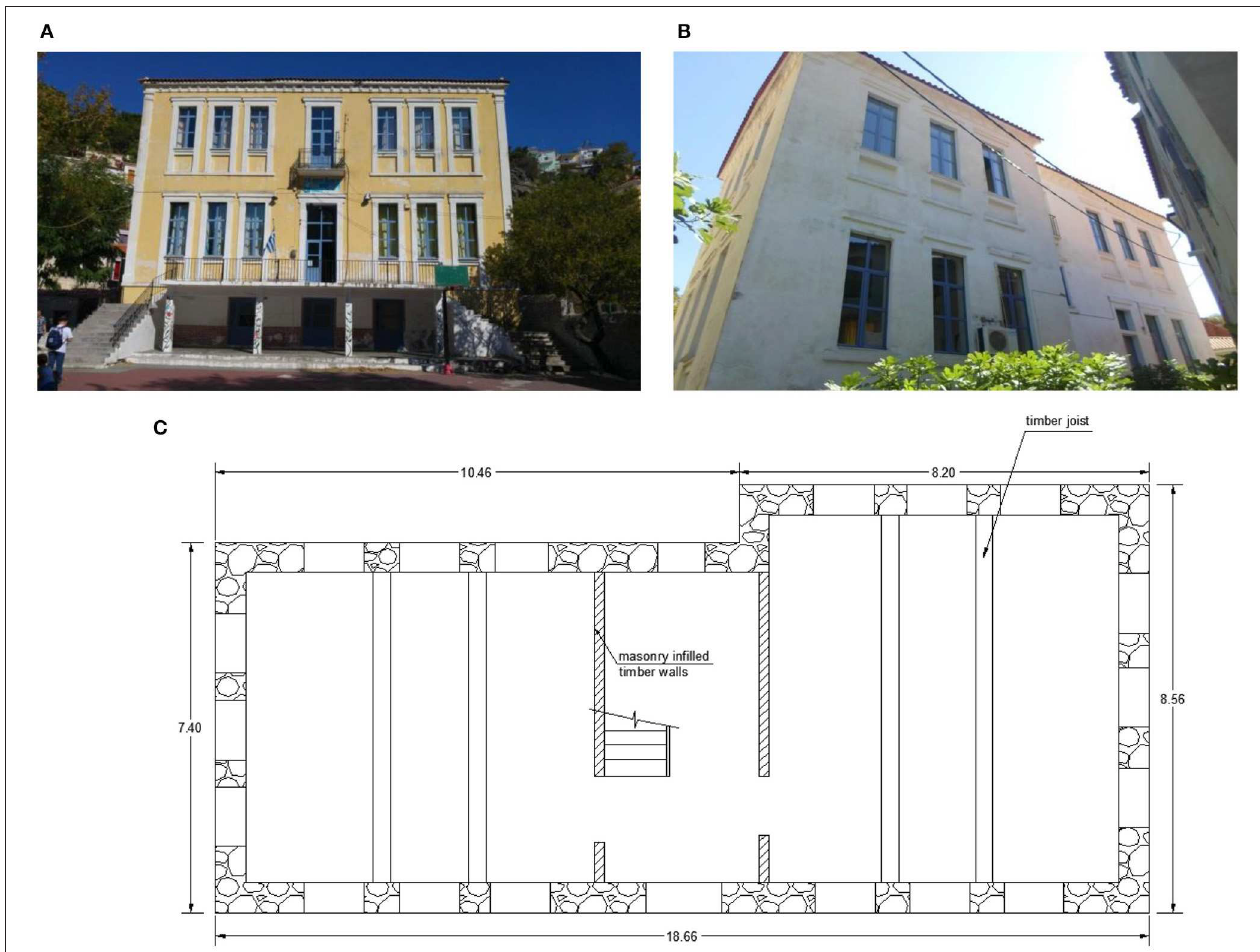
FIGURE 2 | (A) Front view, (B) rear view, (C) typical